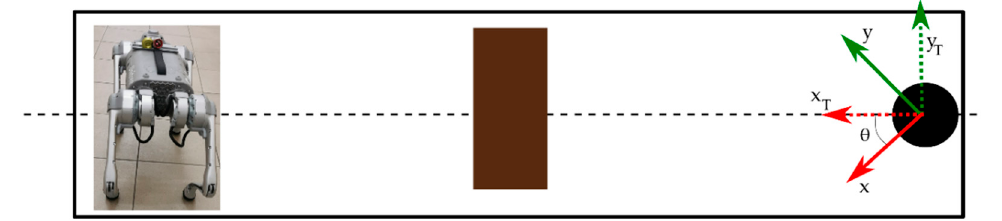
Figure 15. Scheme of a measurement experiment for the GO1 robot.